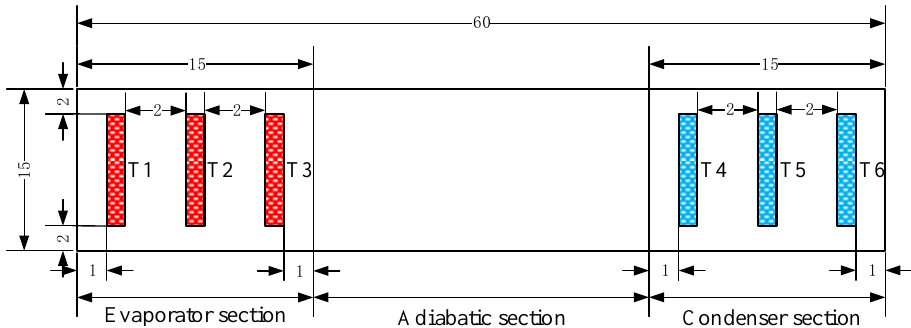
Figure 7. Diagram of the distribution of FMHP surface temperature collection points measured in